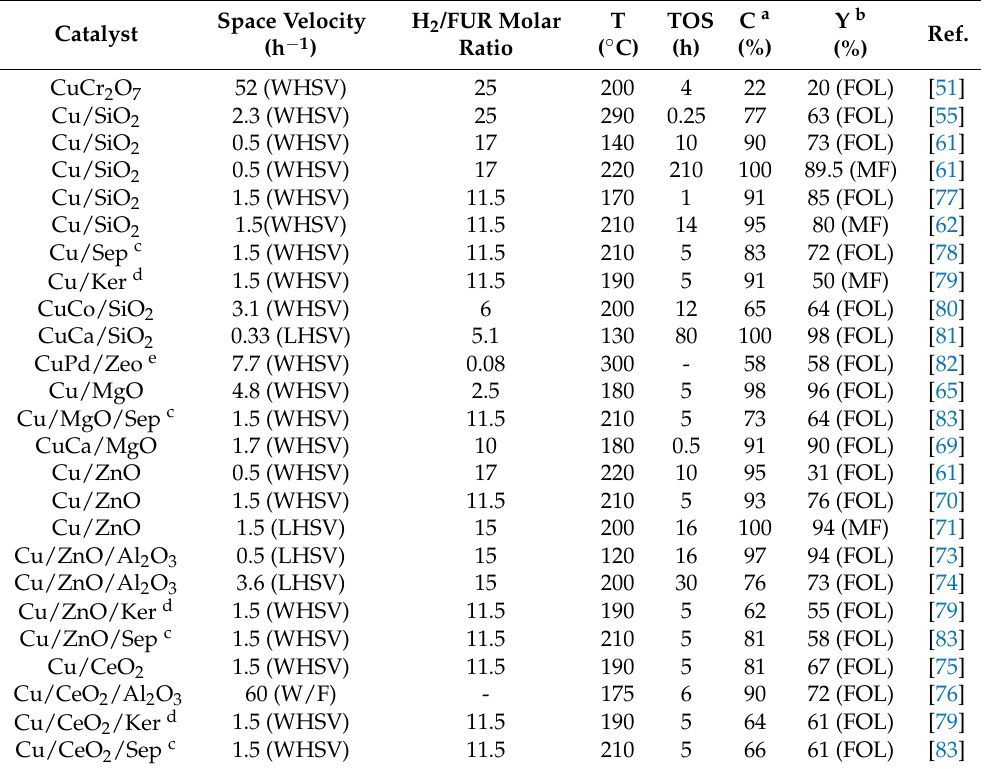
Table 1. Gas-phase hydrogenation of FUR to FOL and MF using Cu-based catalysts and hydrogen as reductant.